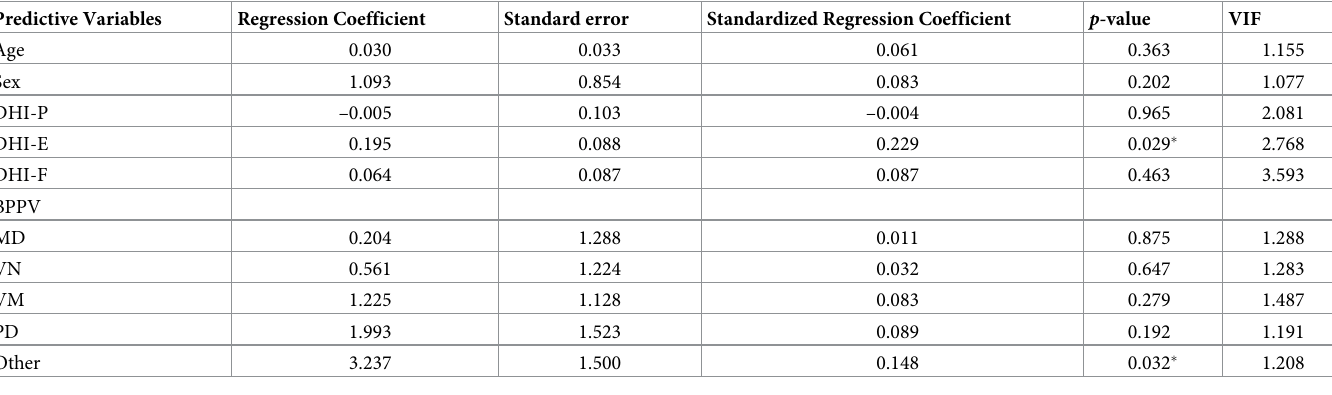
Table 5. Multiple regression analyses of ISI in relation to subscales of DHI, age, sex, and all groups. Predictive